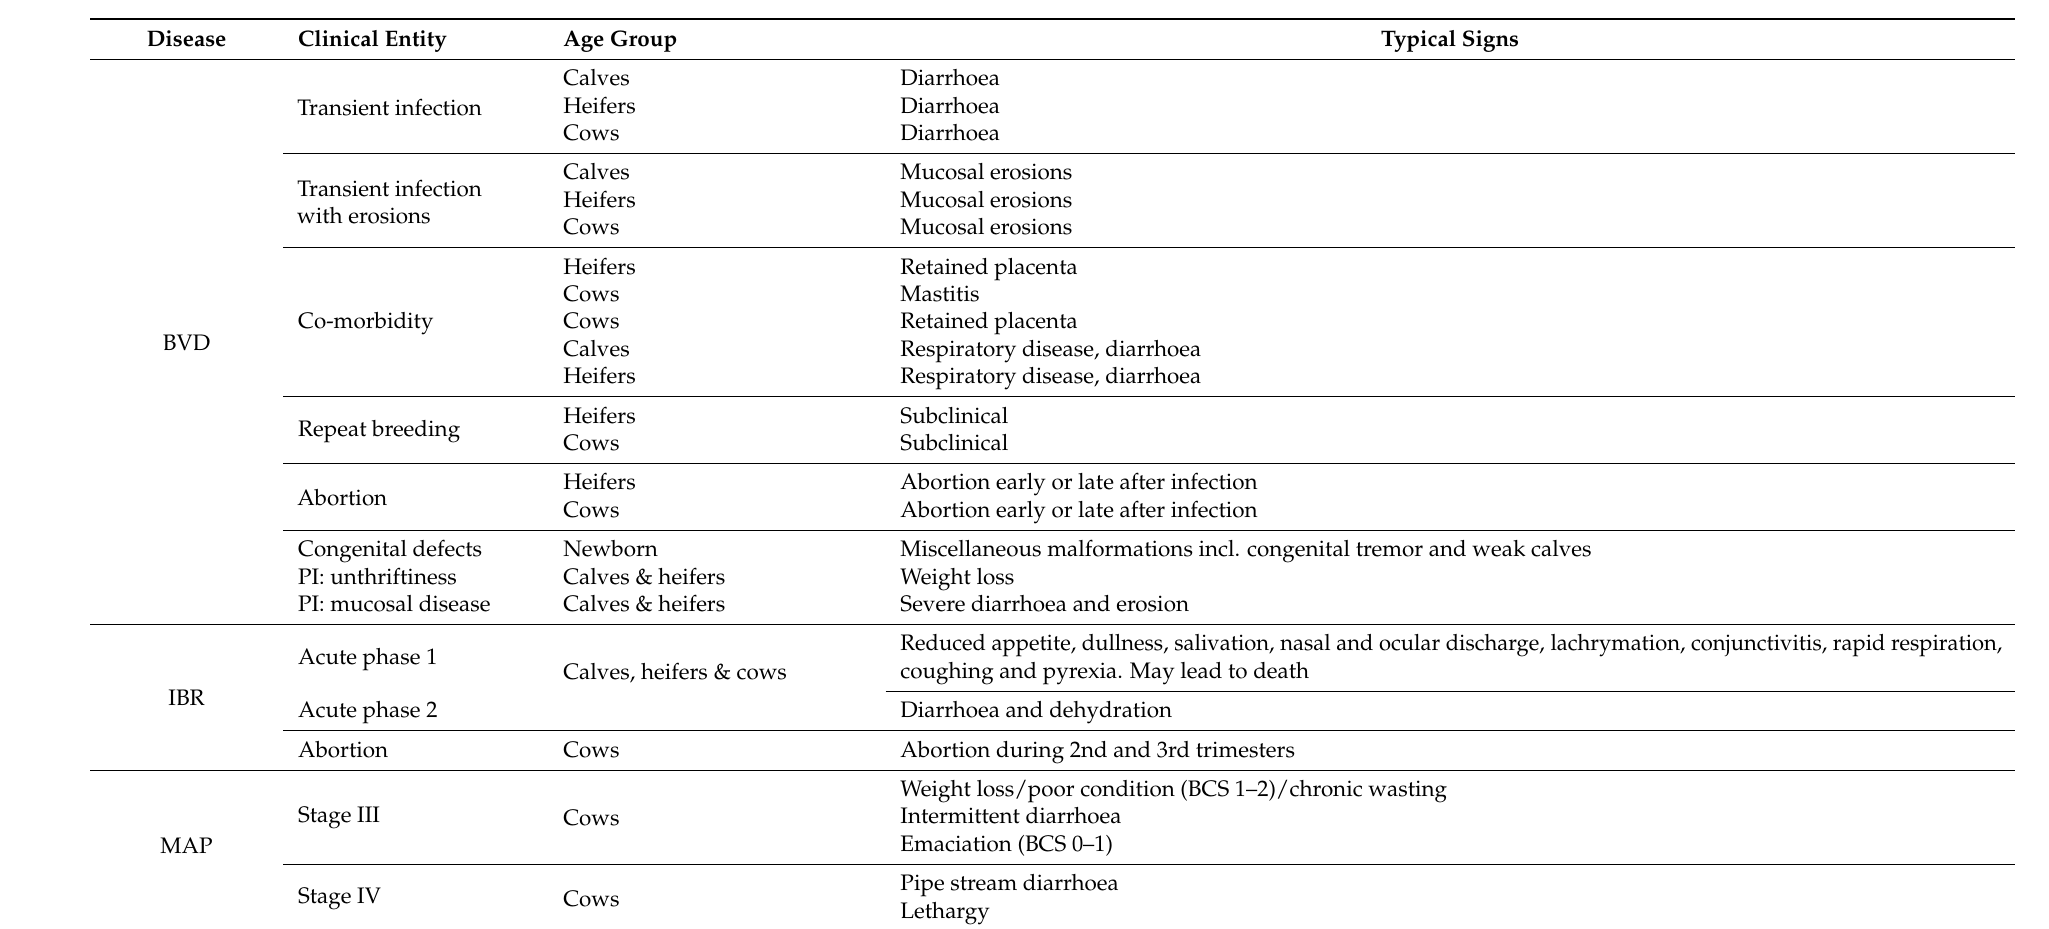
Table 1. Typical clinical signs stratified by clinical disease entities and age group for each of the five diseases 1 , as described in the literature.